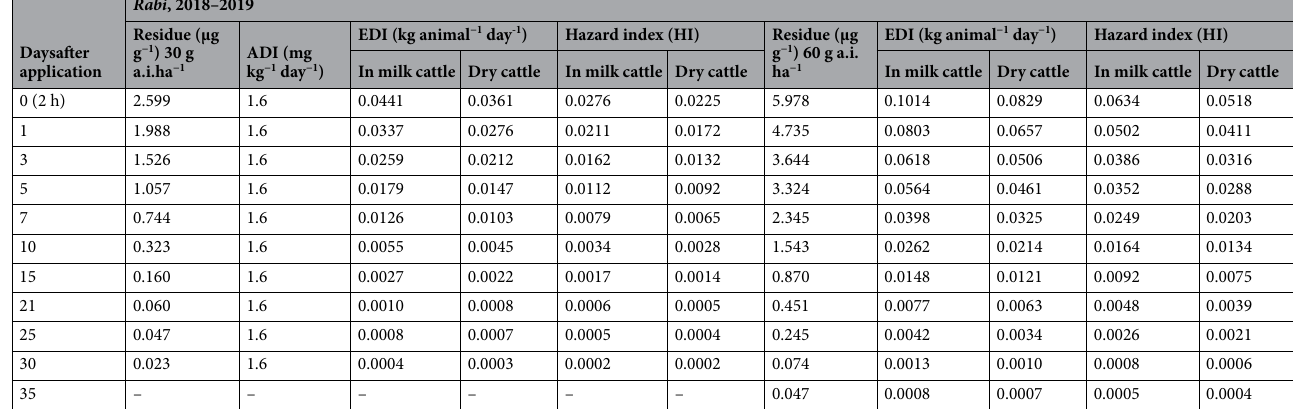
Table 5. Dietary risk assessment of chlorantraniliprole 18.5% WG in cattles during Rabi, 2018–2019. ADI acceptable daily intake, EDI estimated daily intake.